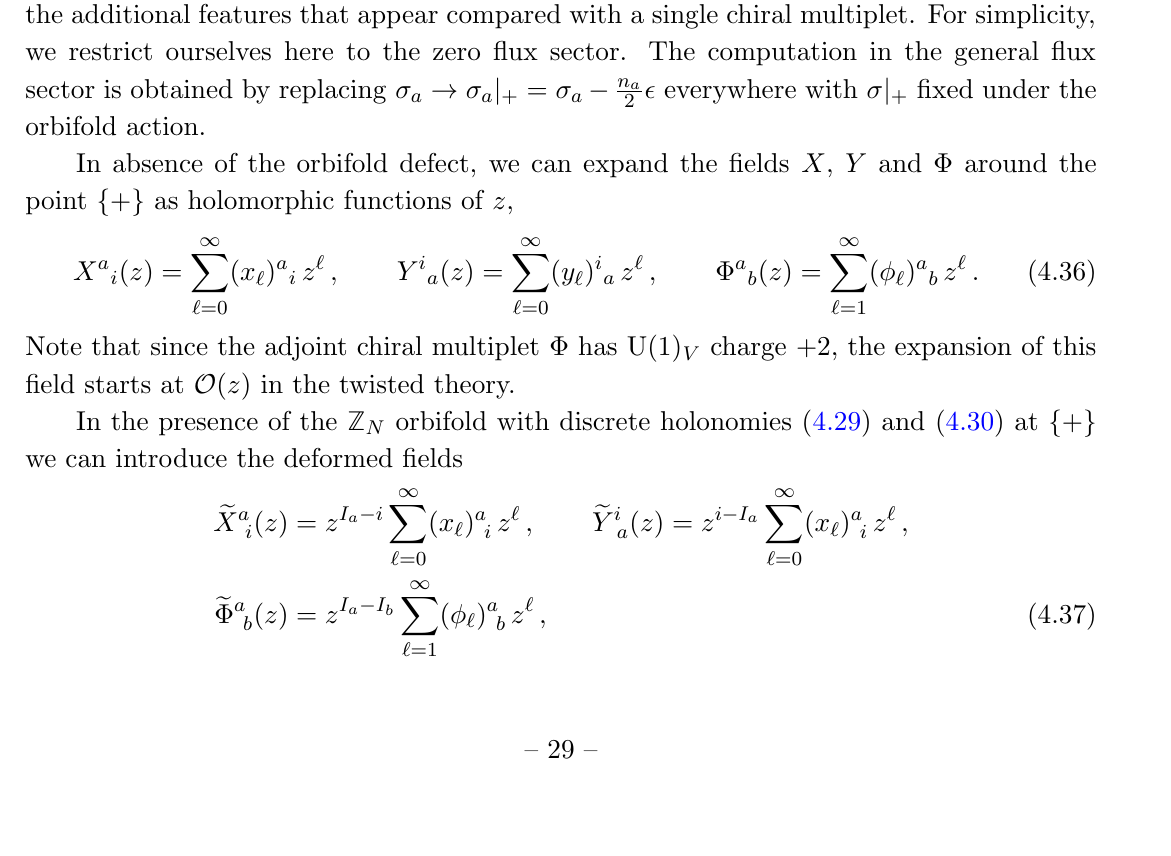
I ( (cid:27) ) for N = 10, k = 4 and I = f 2 ; 4 ; 7 ; 9 g